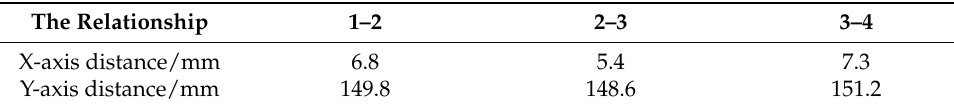
Table 2. Actual distance of modular vehicles with “|” shape.